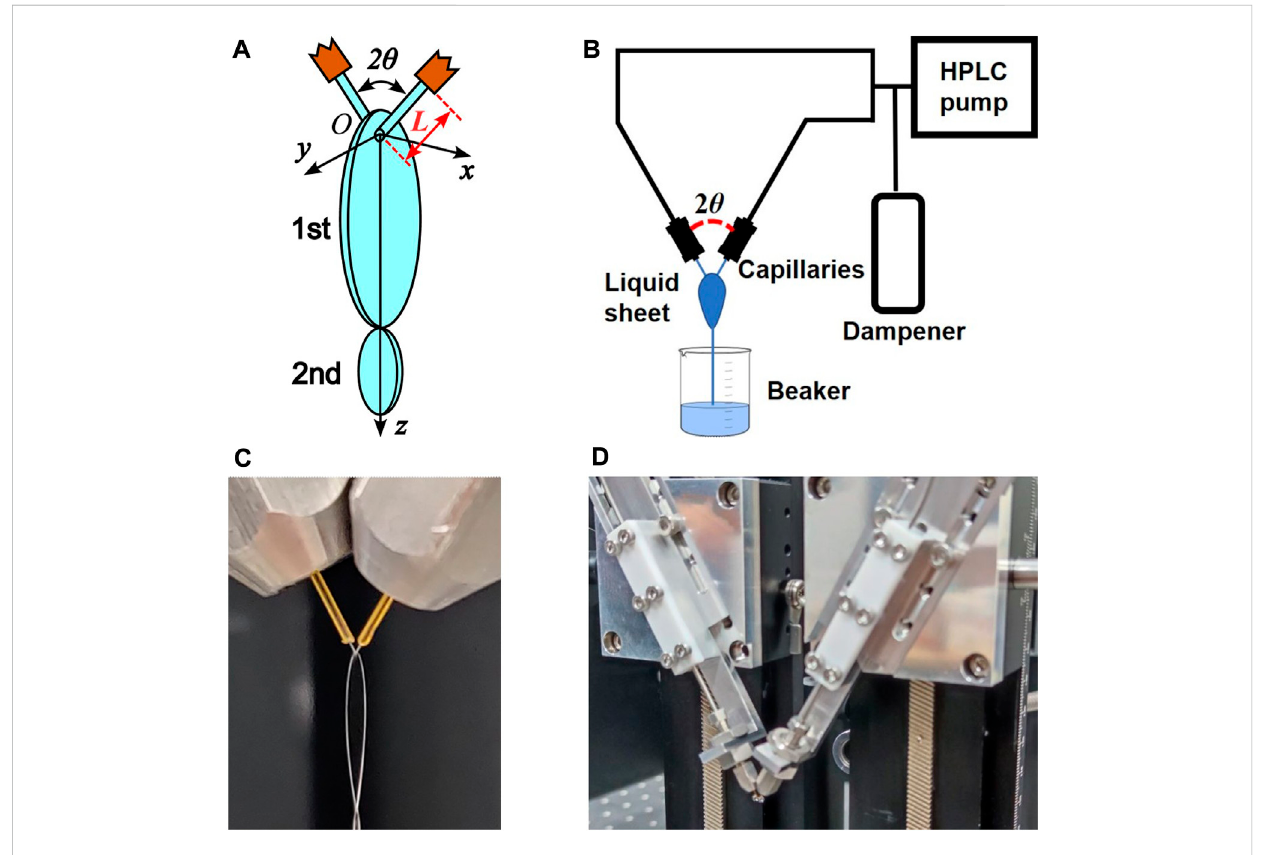
FIGURE 1 (A) Schematic of the liquid sheets generation process in the two-jet-collision regime. (B) Schematic of our liquid-delivery subsystem. (C) Photograph of the generated liquid sheet. (D) Photograph of the capillary positioning